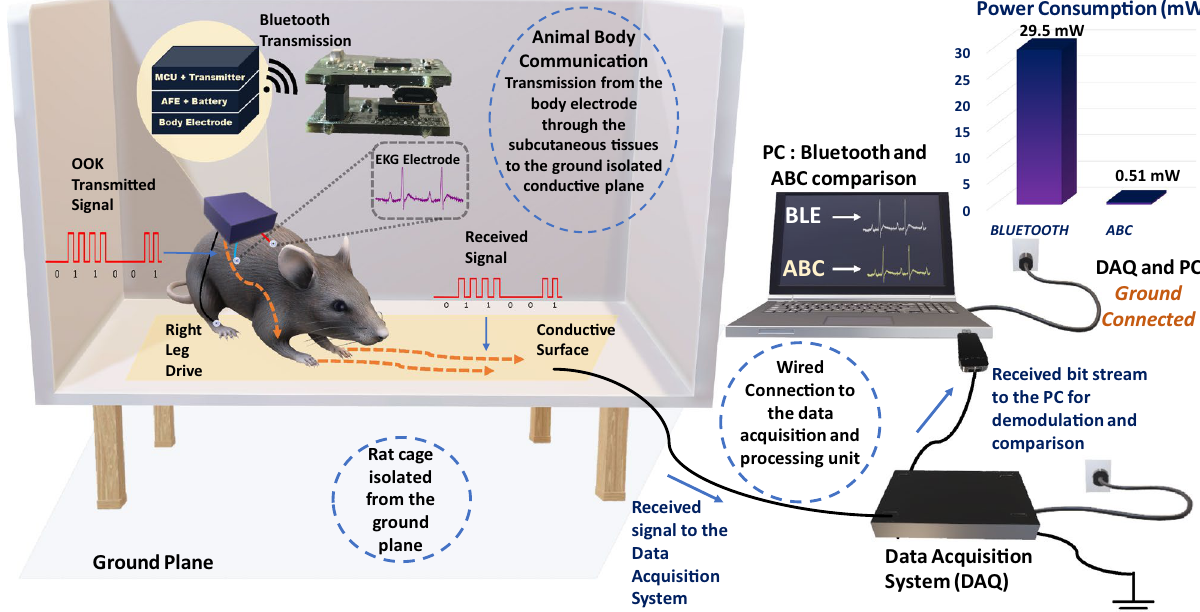
Figure 1. Animal Body Communication: Overview of Animal Body Communication on a Rodent Model. Custom designed sensor node is placed on the back of the rat. This sensor node is capable of sensing and transmitting the surface biopotential signals via Bluetooth and Animal Body Communication. The sensed signal is transmitted through the body to the conductive surface in the form of OOK (On–Off Keying) sequences. The specially designed rat cage is isolated from the ground surface. A conductive surface is placed on the base of the rat cage which is then connected to a Data Acquisition System (DAQ) which receives the transmitted signals. The Bluetooth receiver and DAQ are connected to a PC for processing, with the DAQ and PC ground referenced. In this model Bluetooth communication acts as a validity check for ABC. This figure was created using the software Paint 3D by Microsoft Corporation (Version